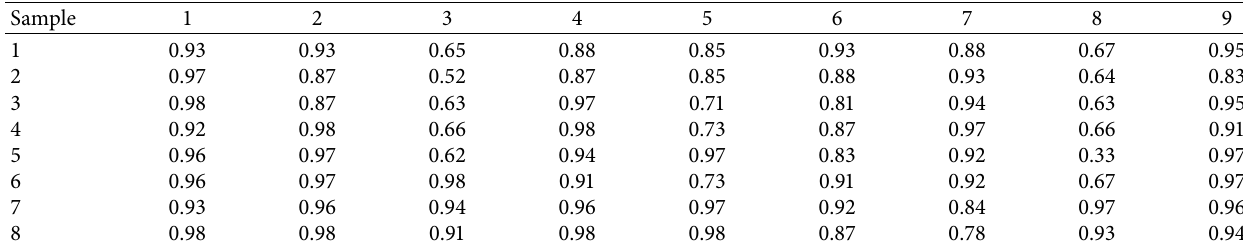
Table 6: Sample data after initialization.